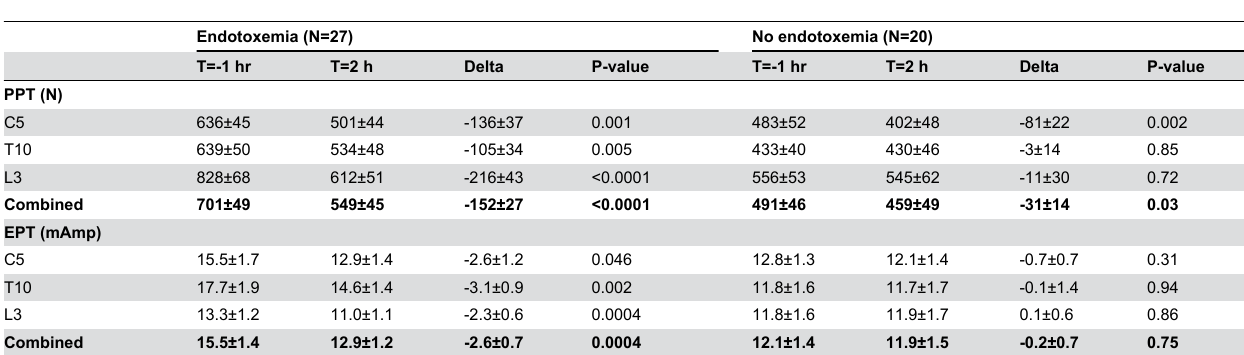
Table 1. Pain thresholds at T=-1 and